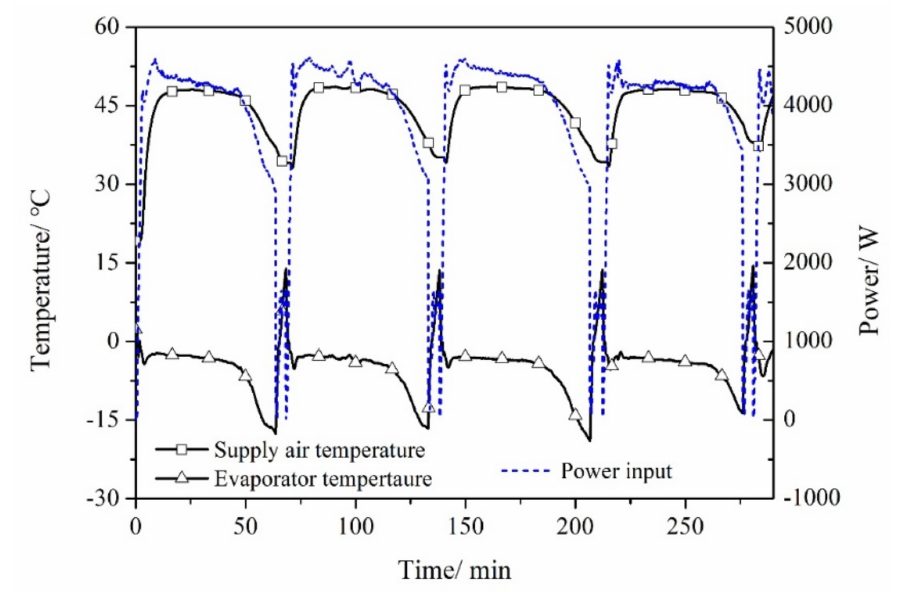
Figure 3. Four consecutive frosting/defrosting cycles in baseline